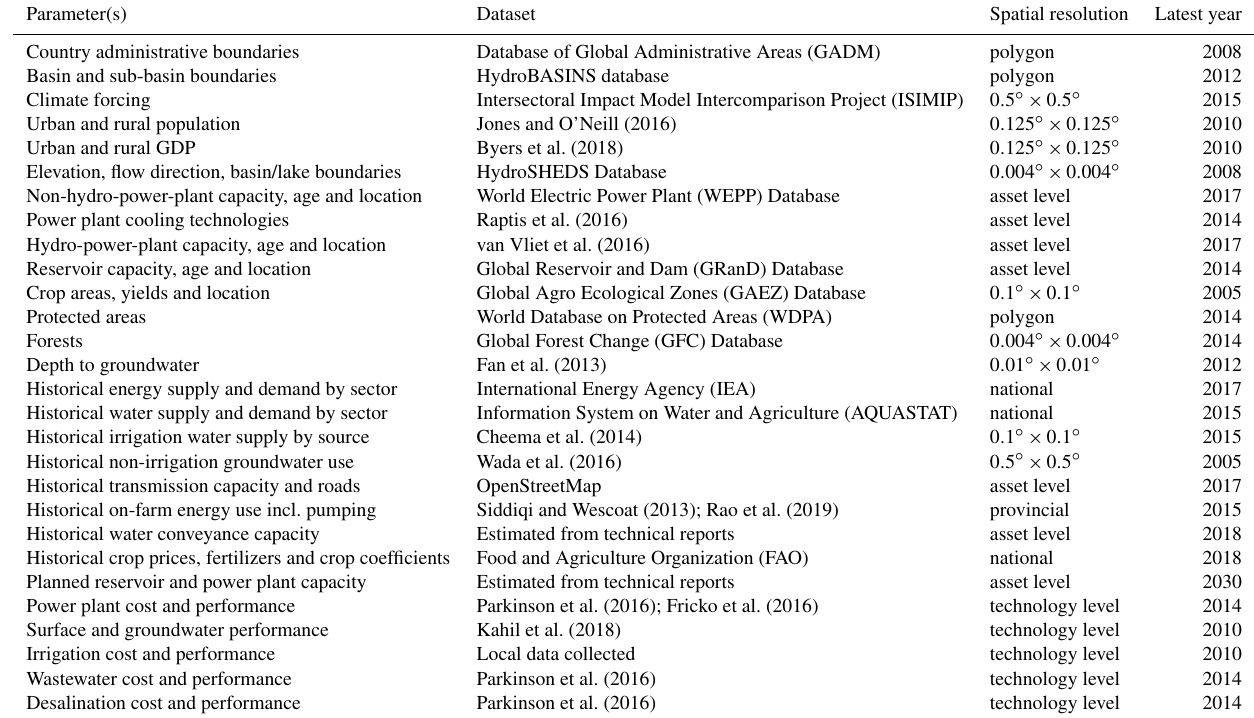
Table 1. Data sources leveraged to parameterize the NEST implementation of the IRB.